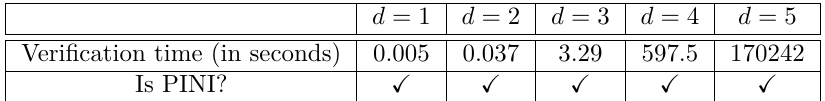
Table 2: Verification outcomes of Mul d +1 using SILVER. d = 1 d = 2 d = 3 d = 4 d = 5 Verification time (in seconds) 0 .